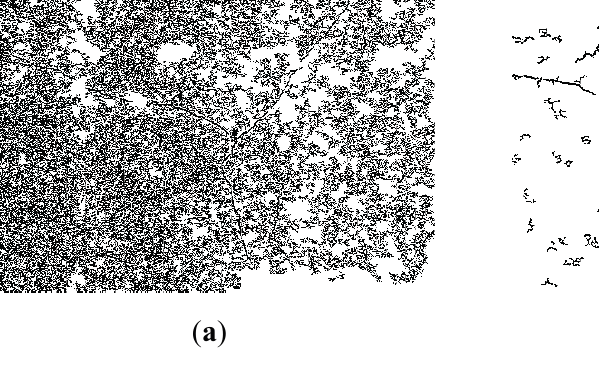
=0, (cid:1840) =650; ( c ) ( d ) (cid:1872) (cid:3028) (cid:3003)